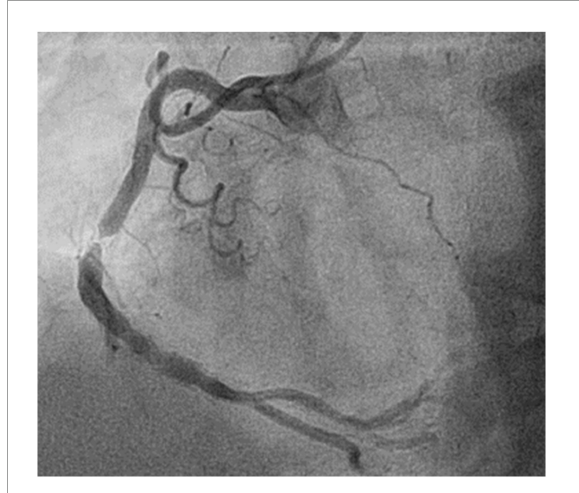
FIGURE1 Angiographic appearance of an in-stent restenosis in segment 2 of the right